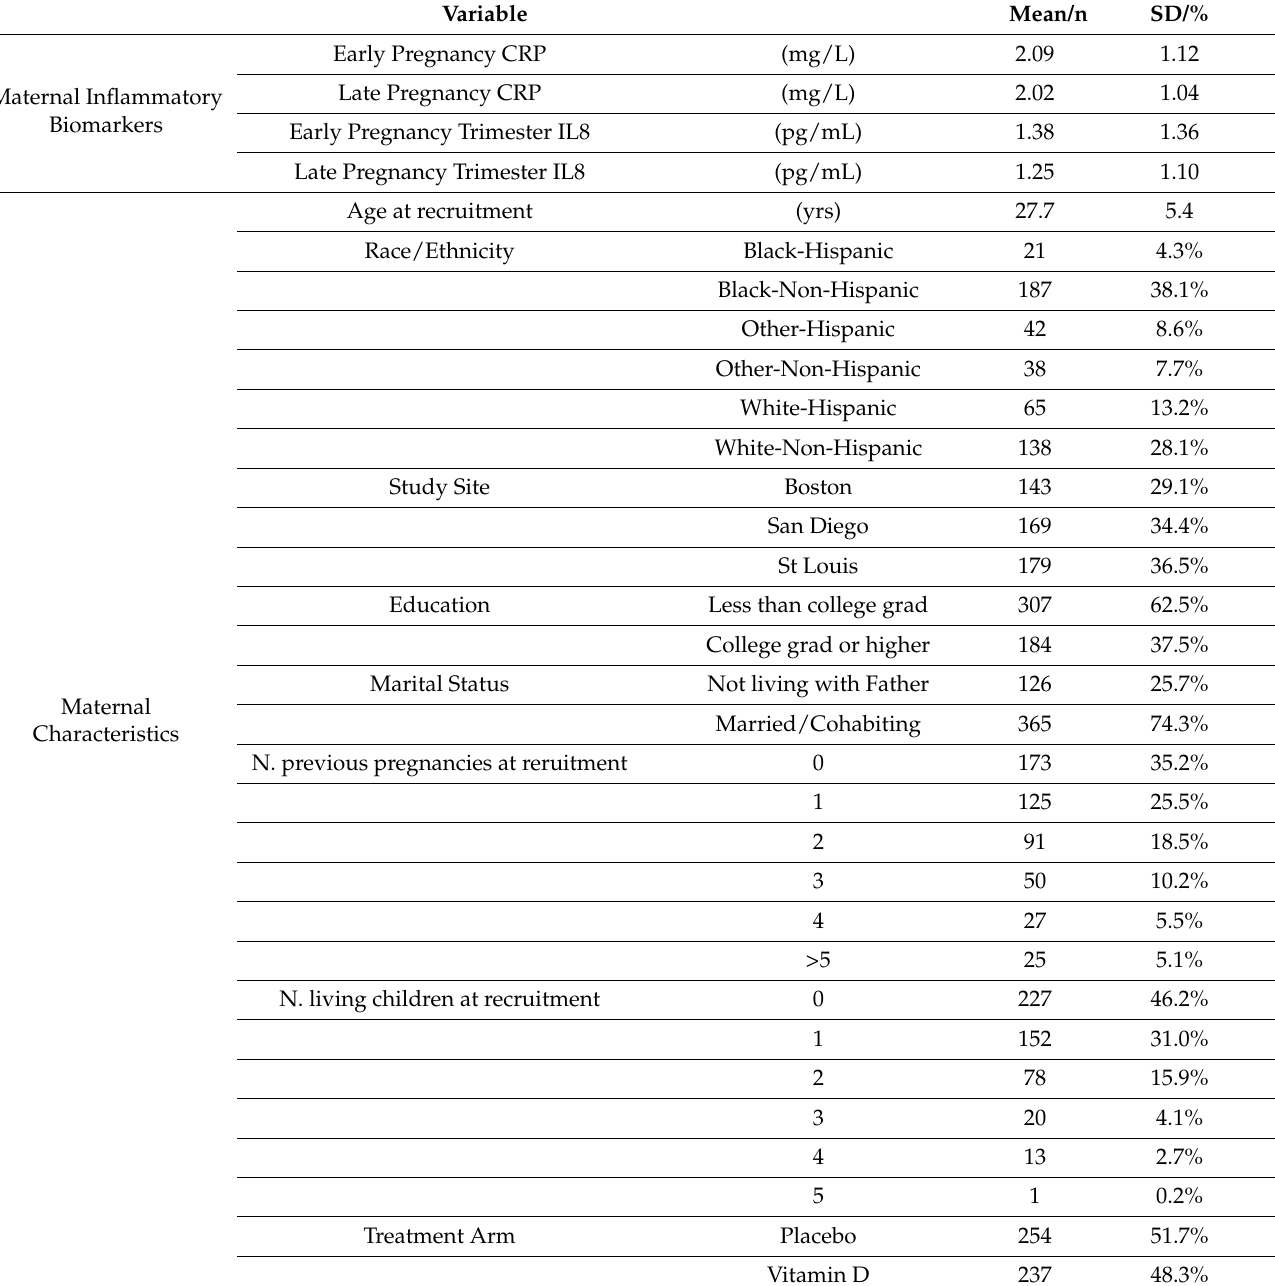
Table 1. Characteristics of 491 VDAART Mother–Child